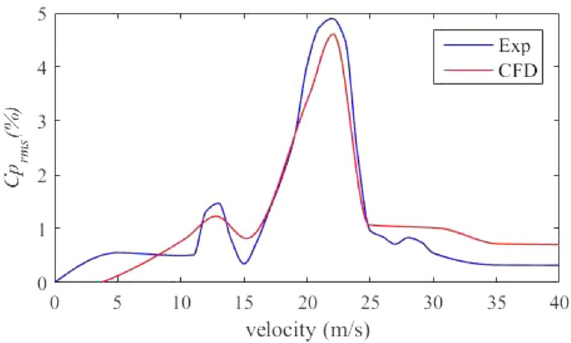
Figure 9. The pressure fluctuation coefficient under each wind